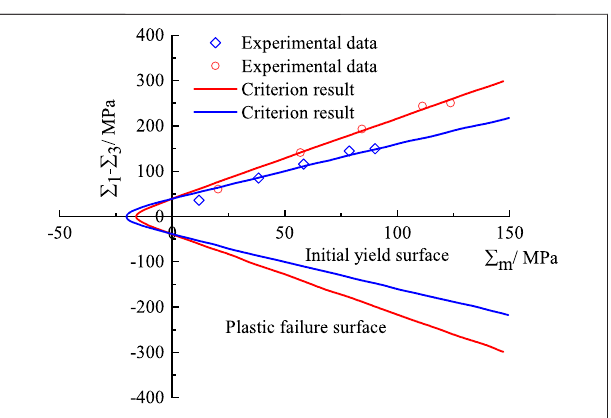
FIGURE 3 | The initial yield surface and plastic failure